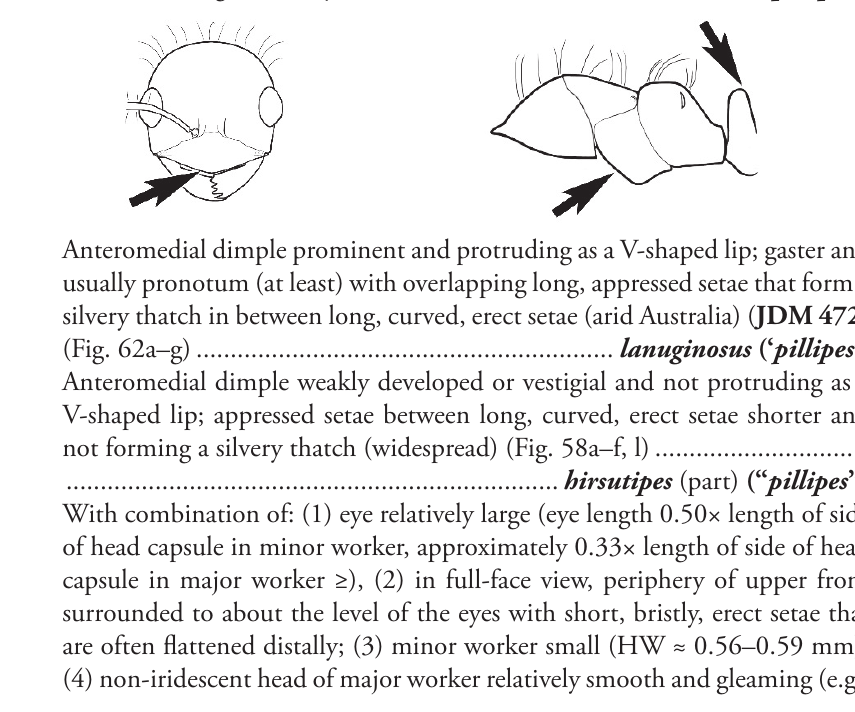
Australian) (Fig. 73m–r, y) ............................................... turneri (‘ pillipes